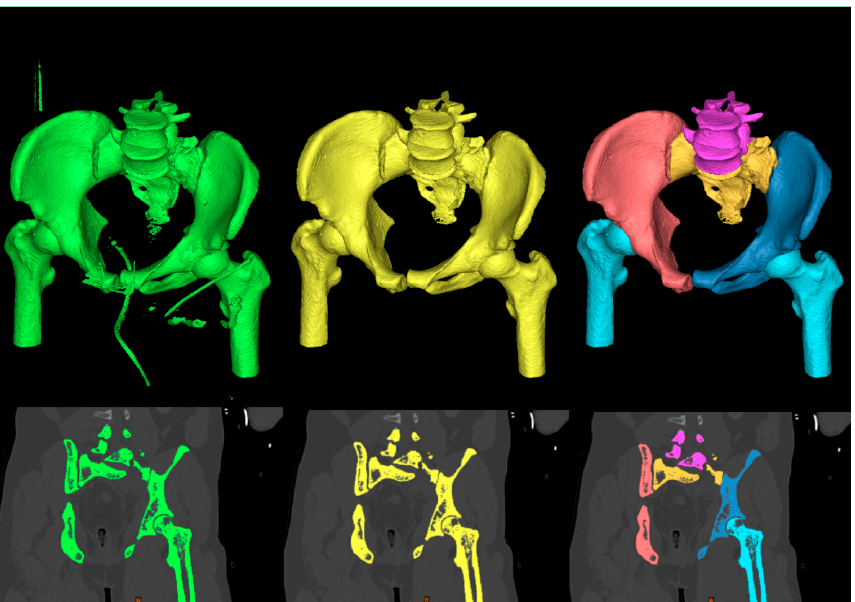
Figure 2. Process of segmenting and separating pelvis from CT slices into individual anatomical structures. Left to right: thresholding output (green color), region growing output (yellow color) and mask splitting output (multiple colors). The top row is a representation of masks in 3D space, and the bottom row is in 2D space.